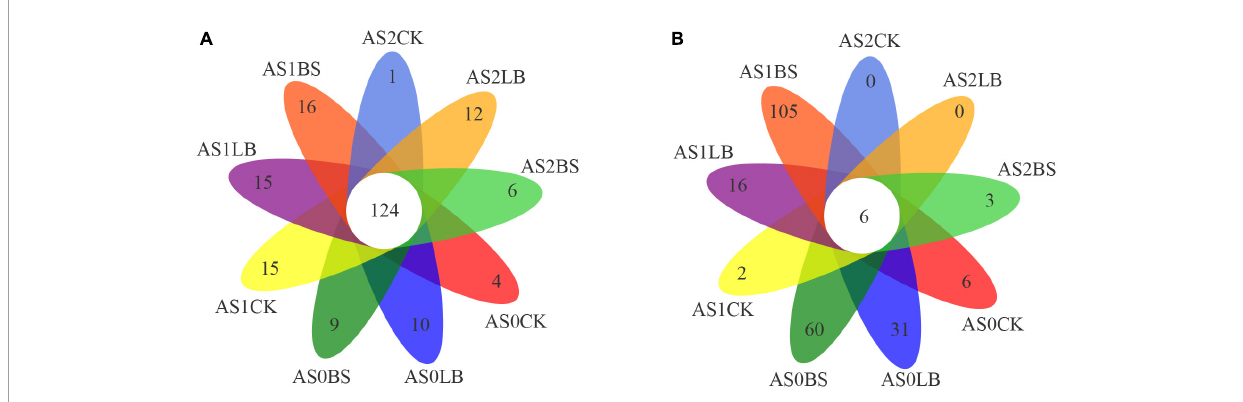
FIGURE4 Venn diagram of bacterial (A) and fungal (B) operational taxonomic units (OTUs) in whole plant corn silage during aerobic exposure. AS0CK, not inoculated silage at 0 h of aerobic exposure; AS0LB, Lentilactobacillus buchneri inoculated silage at 0 h of aerobic exposure; AS0BS, inoculated Bacillus subtilis silage at 0 h of aerobic exposure; AS1CK, not inoculated silage at 18 h of aerobic exposure; AS1LB, Lentilactobacillus buchneri inoculated silage at 18 h of aerobic exposure; AS1BS, inoculated Bacillus subtilis silage at 18 h of aerobic exposure; AS2CK, not inoculated silage at 60 h of aerobic exposure; AS2LB, Lentilactobacillus buchneri inoculated silage at 60 h of aerobic exposure; AS2BS, inoculated Bacillus subtilis silage at 60 h of aerobic exposure.